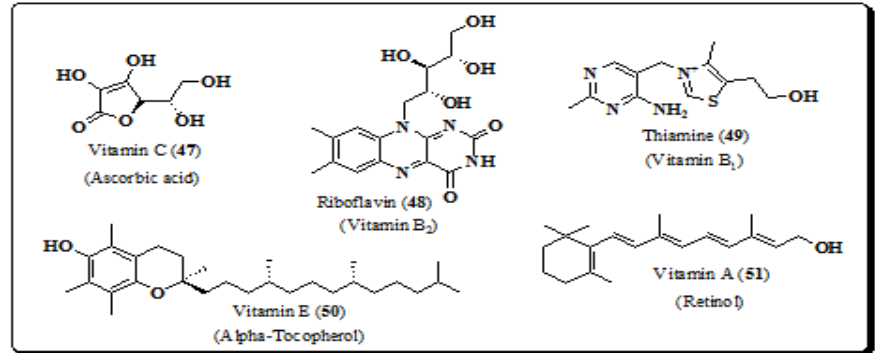
Figure 7. Structures of vitamins from E. laevis ( 47 – 51 ).